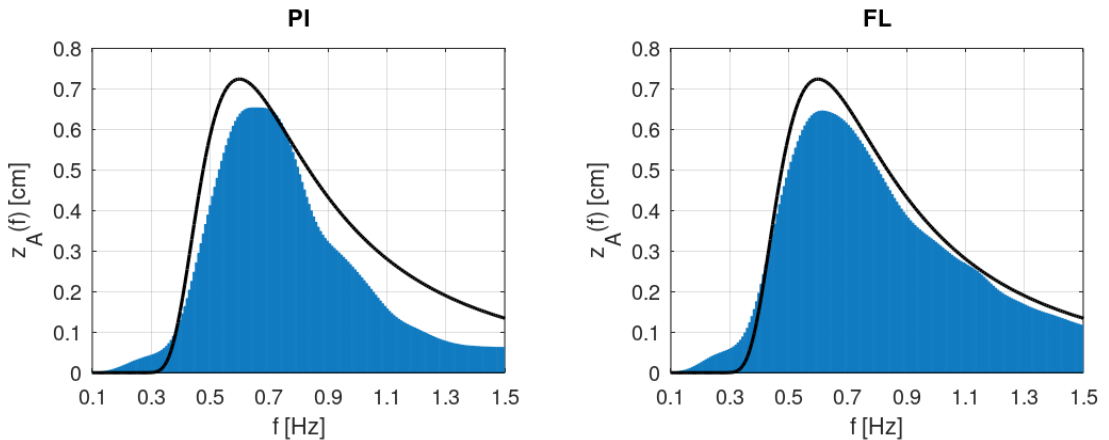
Figure 15. The Pierson-Moskowitz spectra for 5th state of sea in North Atlantic for model scale equal to 1:20—the reference (black lines) and generated under the PI controllers and FL controller (blue bars). The amplitude-frequency characteristics, calculated for the FL versus PI, are presented in Figures 16 and 17. The flatness of the FL-characteristic over the PI-characteristic can be clearly assessed.